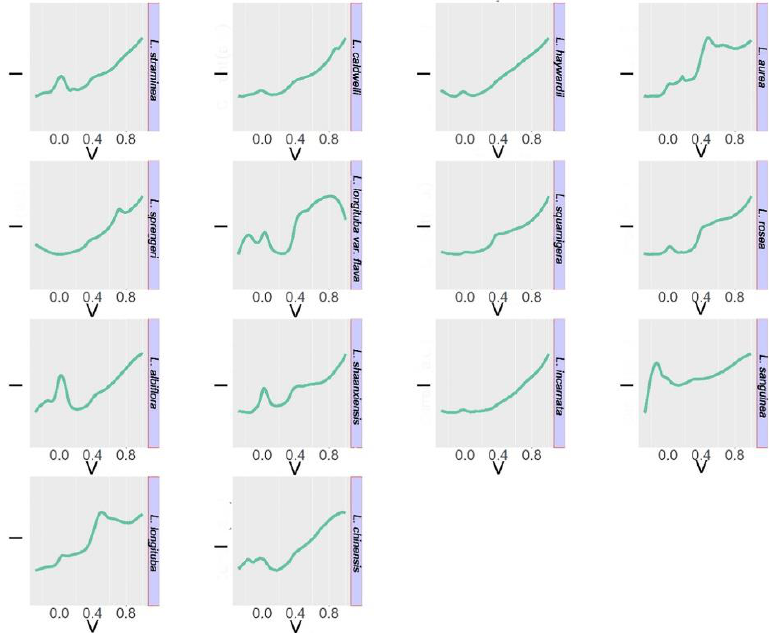
Figure 4. The normalized current values of differential pulse voltammetry responses on screen- printed electrodes using digital photos of 14 flowers of Lycoris species vs. Ag/AgCl after ethanol extraction. Reprinted with permission from reference [57], Elsevier, 2019.